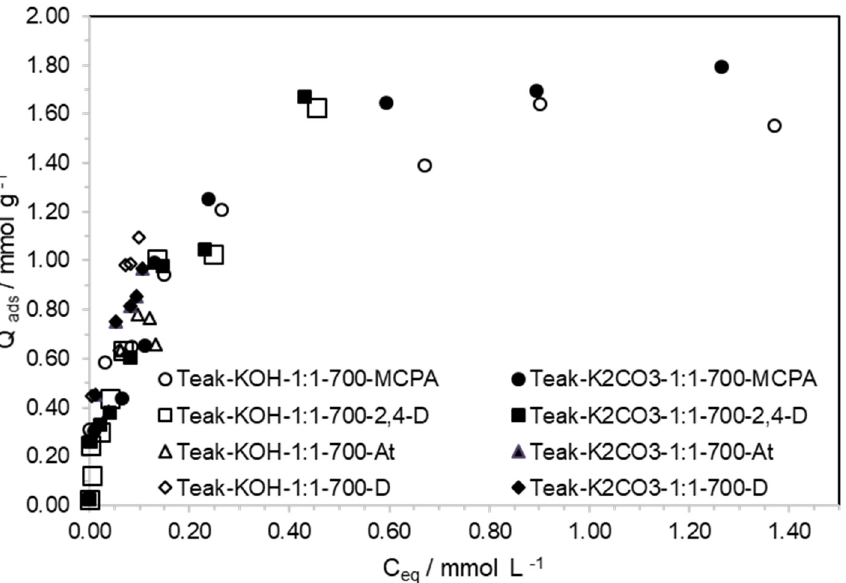
Figure 5. Adsorption of MCPA, 2,4-D, atrazine and diuron on ACs prepared from Teak, activated with KOH or K 2 CO 3 , at 973 K. (Teak-KOH-1-1-700 is the ACs designation and the last letters refer to the pesticides studied; At means atrazine and D means diuron.)